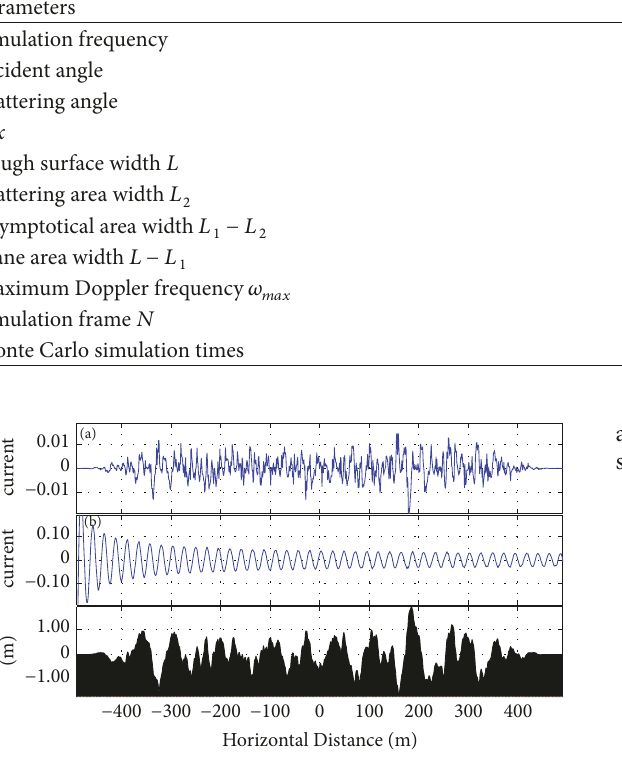
Figure 5: Surface current distribution over wave profile. (a) The incoherent surface current 𝜓 𝑠 calculated by the method in this paper. (b) The total surface current 𝜓 calculated by the conventional integral equation method with incident plane